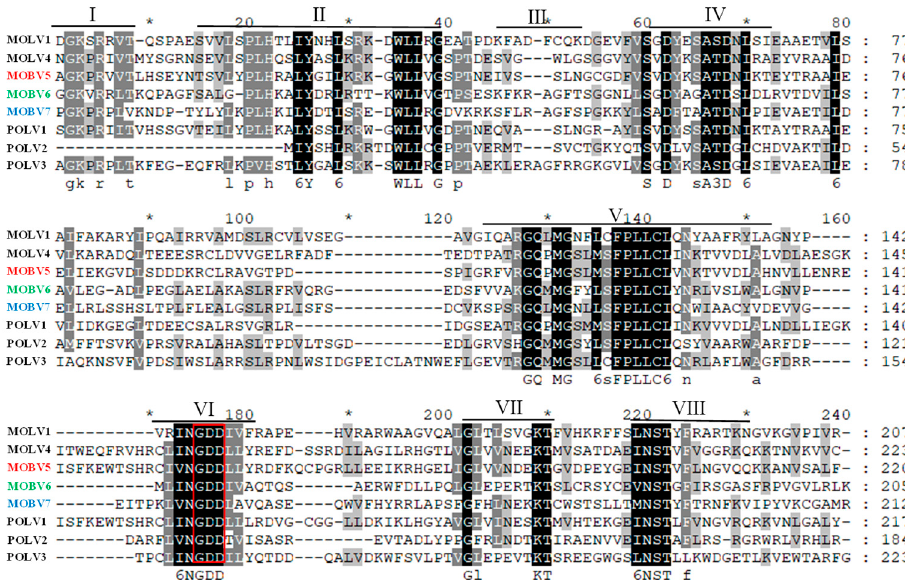
Figure 4. Multiple alignment of the amino acid sequences of RdRp encoded by MOBV5, MOBV6, and MOBV7 and previously identified Magnaporthe oryzae ourmia-like viruses (MOLV1 and MOLV4). The conserved motifs in the RdRp of the compared viruses are shown by roman numerals I to VIII. Identical residues are color-highlighted with a black shadow, while conserved and semi-conserved amino acid residues are colored-highlighted with a gray shadow. The red box in domain VI showed the highly conserved GDD motifs in botourmiaviruses. The multiple sequence alignment was performed using the CLUSTALX 1.8 program.